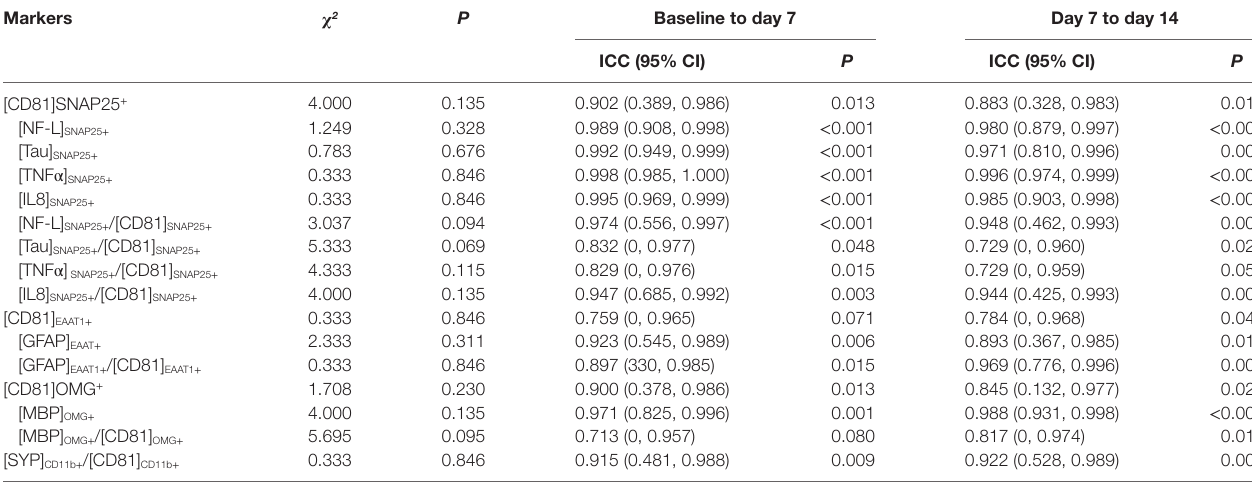
TaBle 1 | Stability of biomarker levels across three time points.